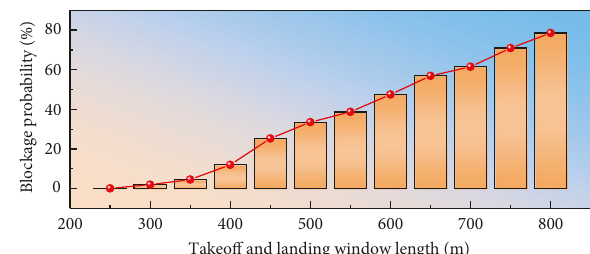
Figure 13: Influence of different takeoff and landing window lengths on the blockage probability.